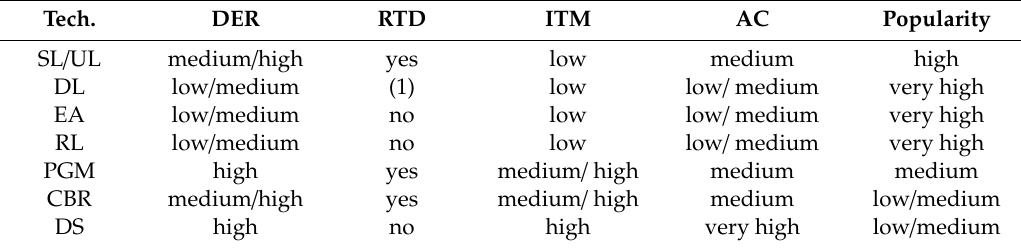
Table 1. Table presenting a comparison of the di ff erent learning techniques discussed. The di ff erent aspects comprising the comparison are scored according to an overall score, as these values may di ff er according to specific algorithms (or variations thereof), research topics, or even game genres. The acronyms used stand for respectively: Domain Expertise Required (DER), Requires a Training Dataset (RTD), Interpretability of the Trained Model (ITM) and Authorial Control (AC). In the